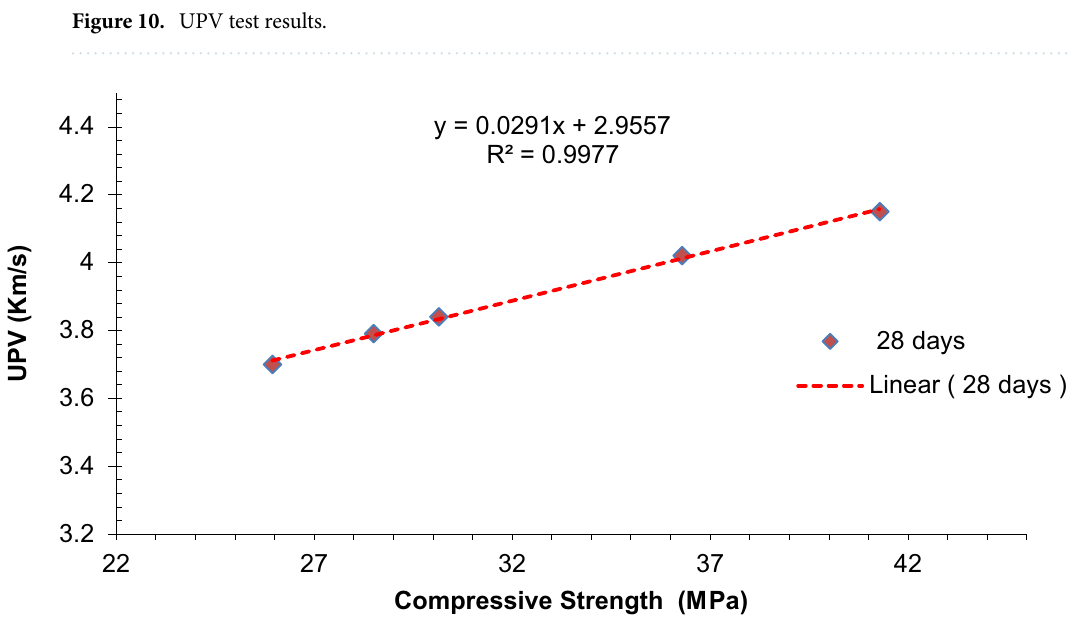
Figure 11. Co-relation between UPV and compressive